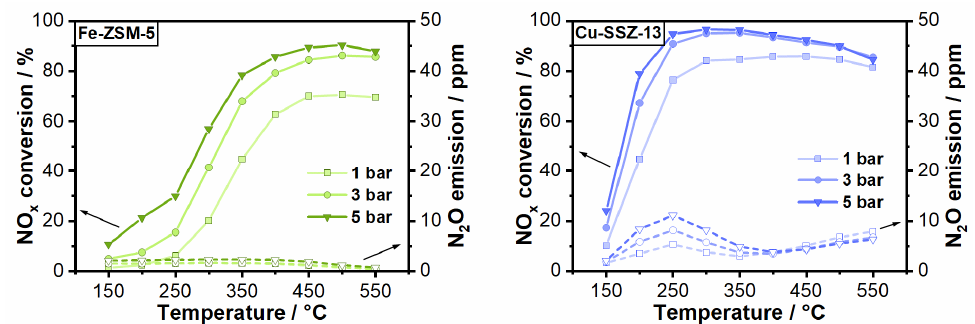
Figure 4. NO x conversion and N 2 O emission of Fe-ZSM-5 ( left ) and Cu-SSZ-13 ( right ) during standard SCR conditions (350 ppm NO, 350 NH 3 , 14% O 2 , 4.5% H 2 O in N 2 ) at a GHSV of 100,000 h − 1 and varying pressure from 1 to 5 bar.